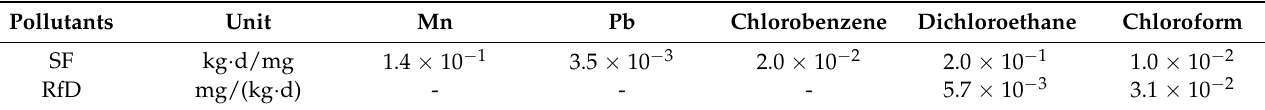
Table 5. Carcinogenic slope factors and reference dose values of toxic and hazardous pollutants.